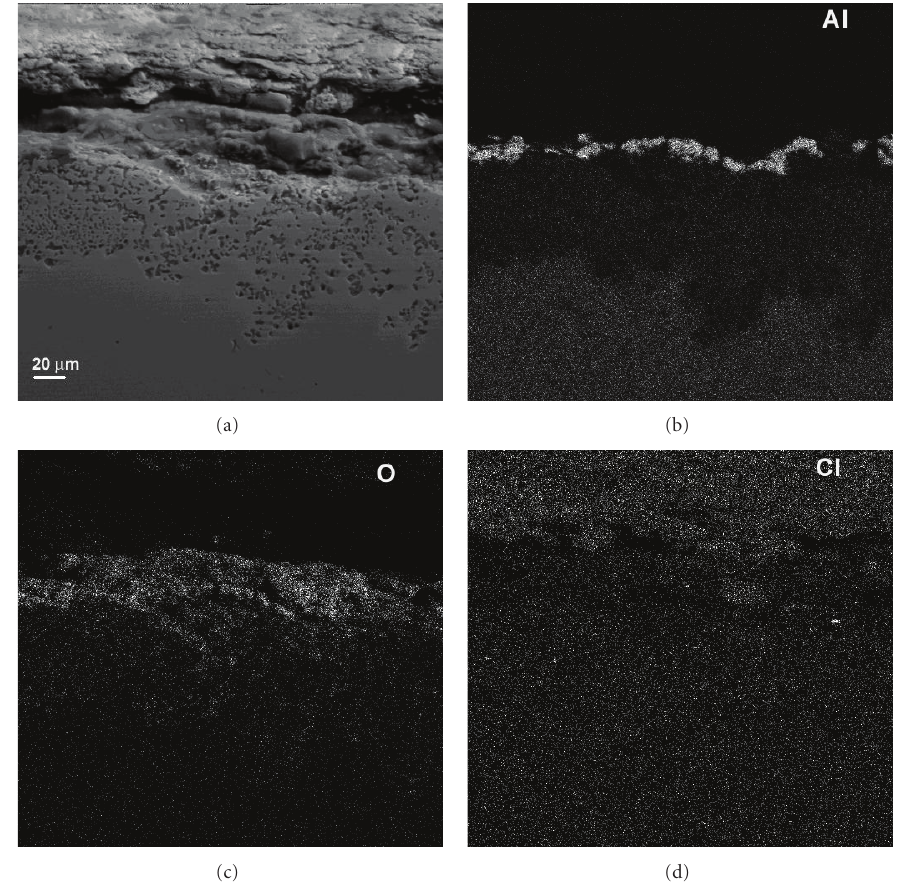
Figure 7: Micrograph of Fe40Al alloy corroded in NaCl-KCl at 670 ◦ C together with the X-ray mappings of Al, O, and